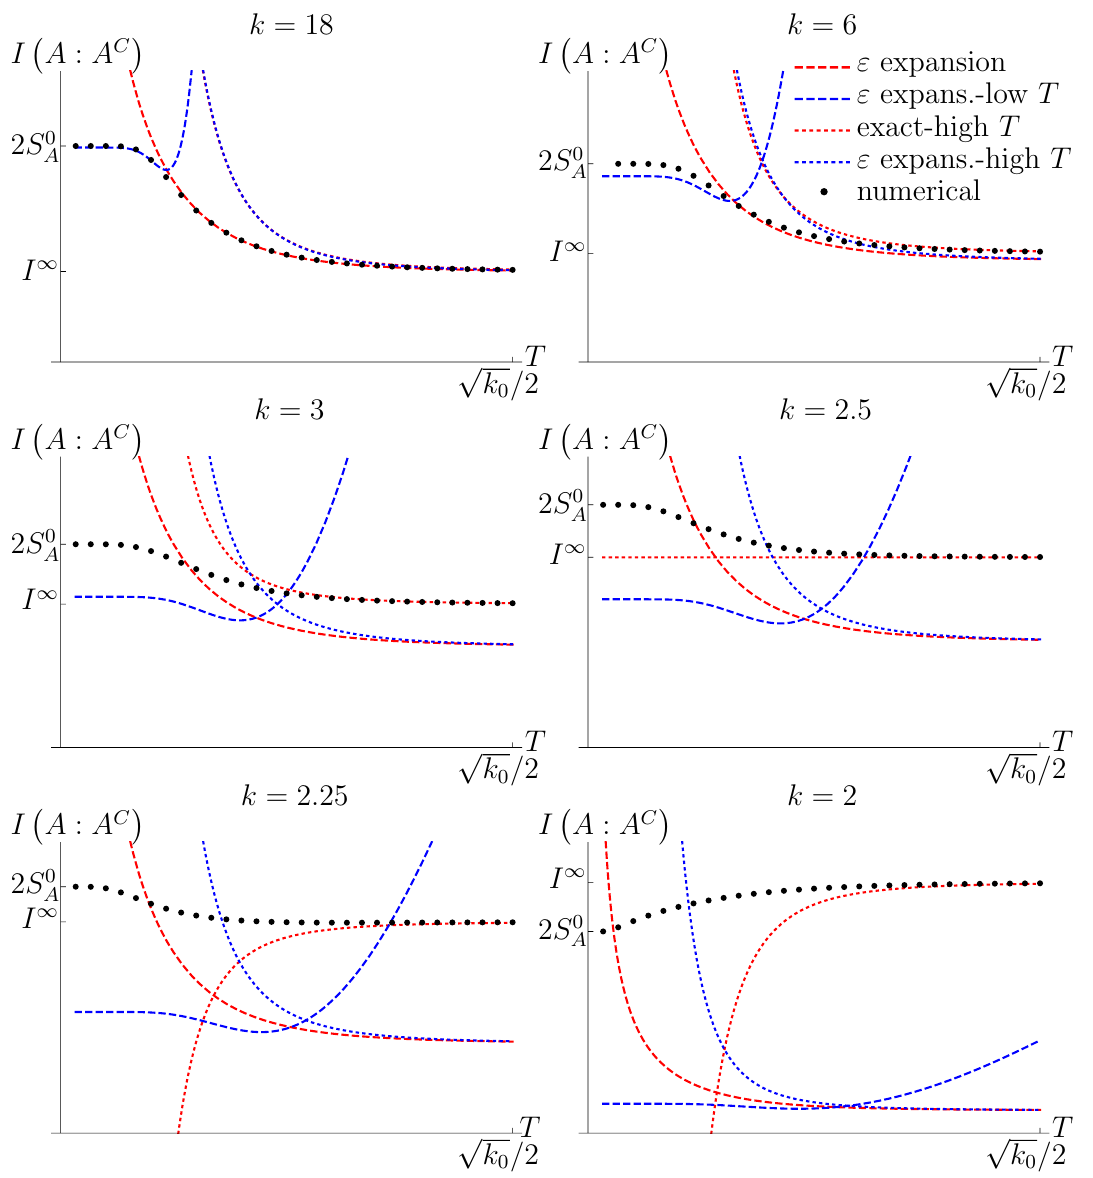
Figure 3 . The mutual information as function of the temperature for the chain of oscillators (4.38) for viarious values of the parameter k